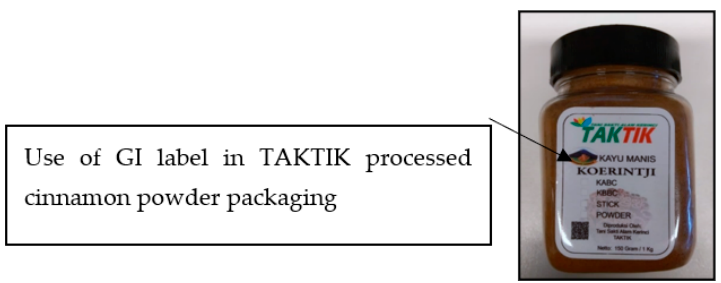
Figure 13. TAKTIK powder cinnamon packaging with GI Koerintji label.